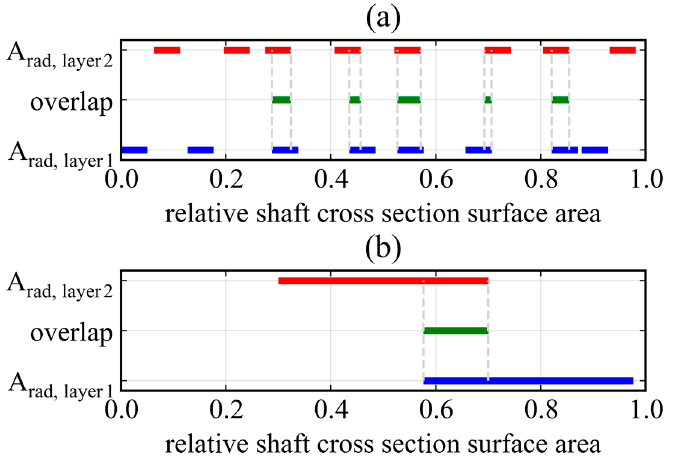
Figure 8. Exemplary representations for the randomized overlap calculation ( a ) using eight individual scrap pieces, ( b ) using one.